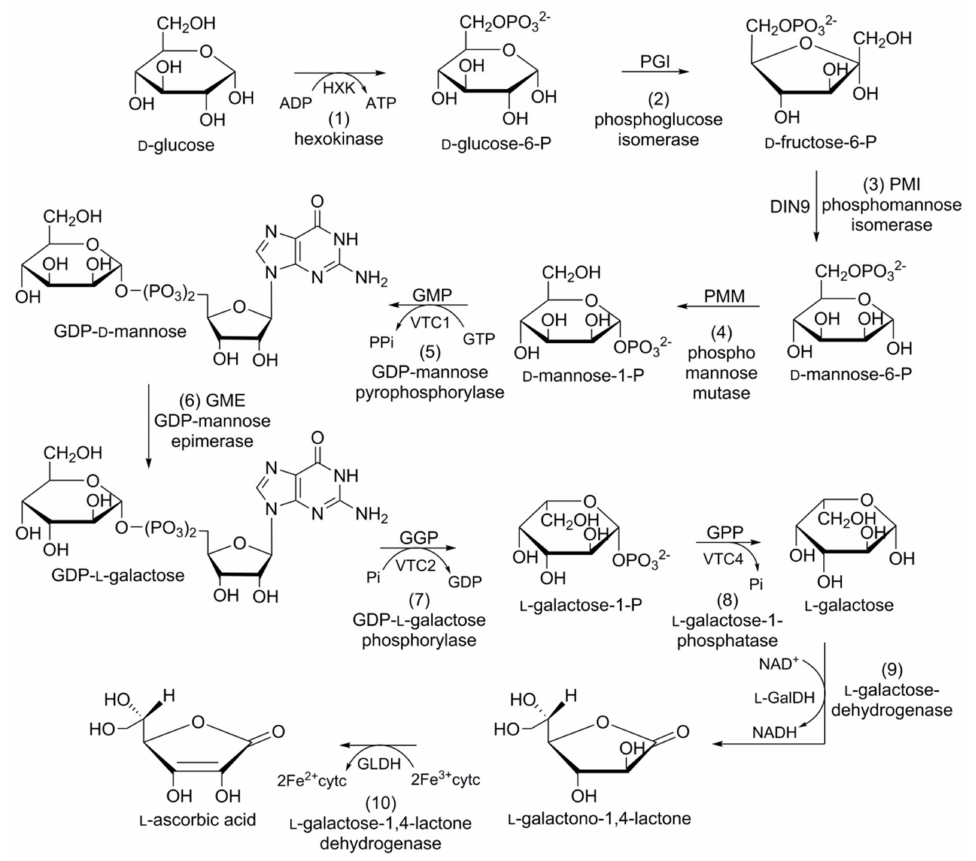
Figure 7. Schematic representation of the biosynthetic pathway of ascorbic acid in carrot: (1) hexokinase; (2) phosphoglucose isomerase; (3) phosphomannose isomerase; (4) phosphomannose mutase; (5) guanosine diphosphate (GDP)-mannose pyrophosphorylase; (6) GDP-mannose epimerase; (7) GDP- l -galactose phosphorylase; (8) l -galactose-phosphatase; (9) l -galactose-dehydrogenase; (10) l -galactose- 1,4-lactone